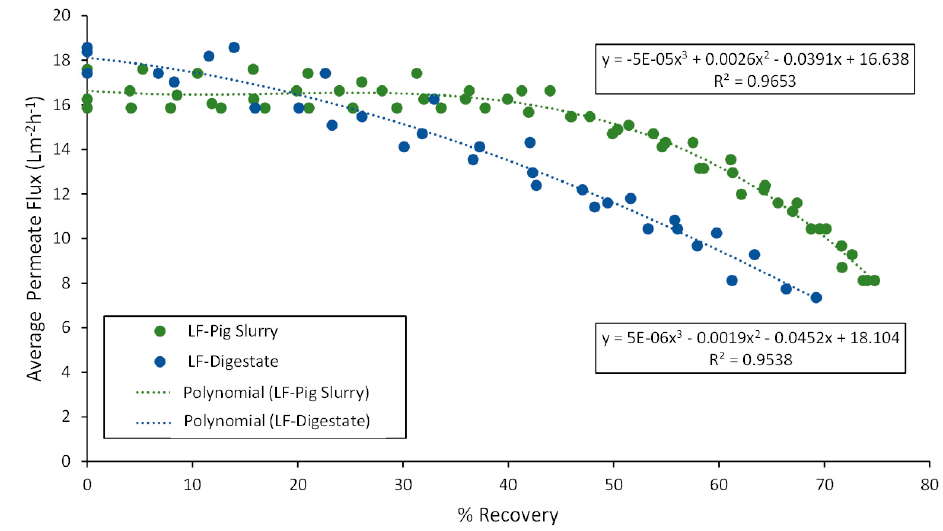
Figure 4. Average permeate flux as a function of permeate recovery for the LF-pig slurry and LF-digestate tested in the screening study.